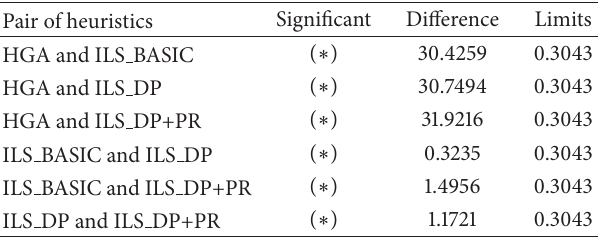
Table 9: Multiple comparisons test. ( ∗ ) denotes a statistically significant difference.